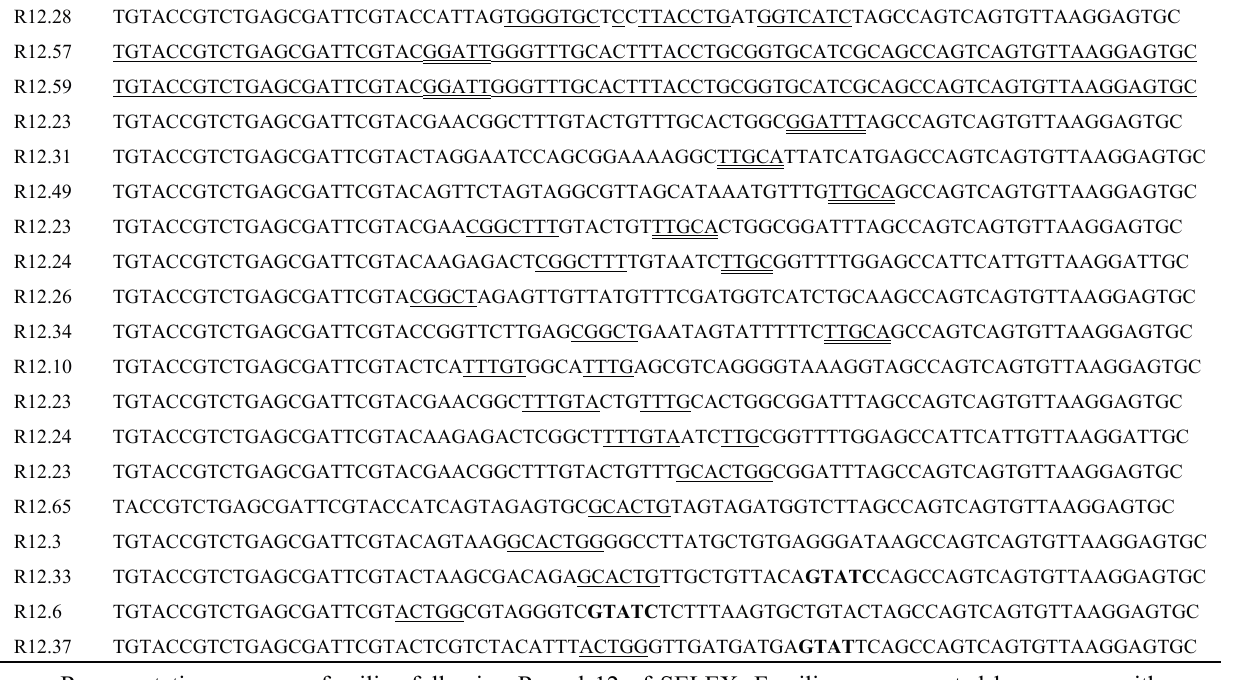
Table 2. Sequence families obtained after 12 rounds of SELEX.